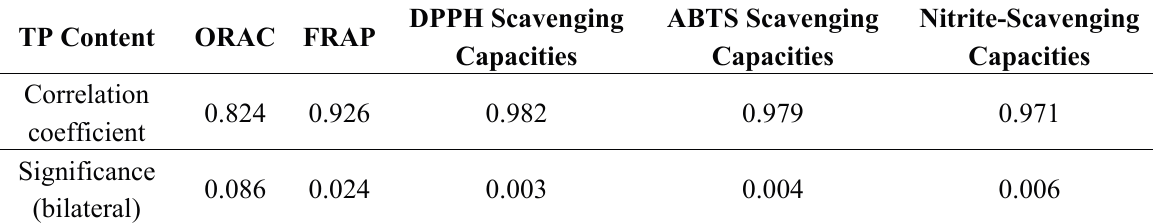
Table 1. Correlation analysis of total phenolic content and antioxicant